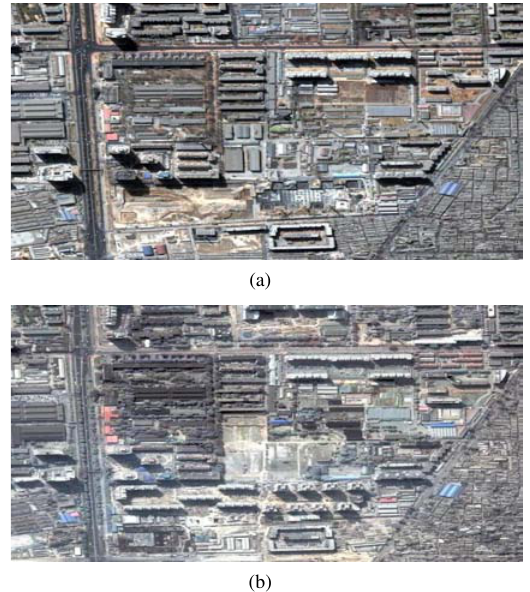
Figure 5: Images used in this paper. (a)Image taken in 2002. (c)Image taken in 2003.